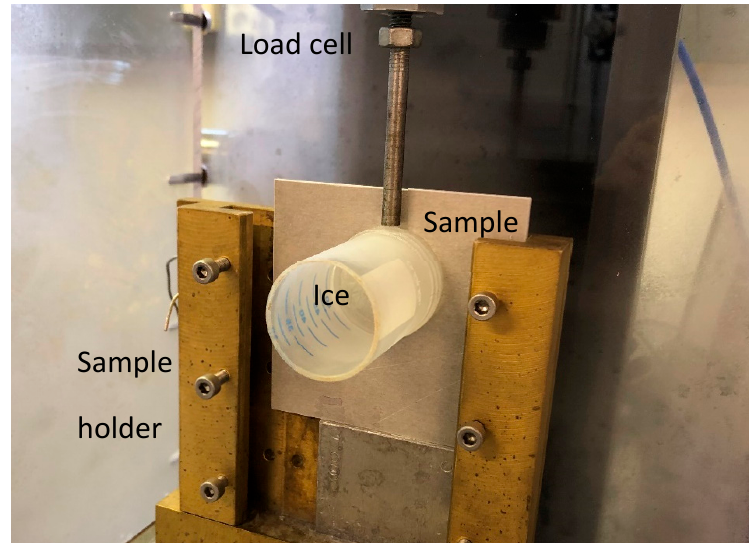
Figure 3. Vertical shear test (VST) as utilized at NTNU to measure ice adhesion strength.